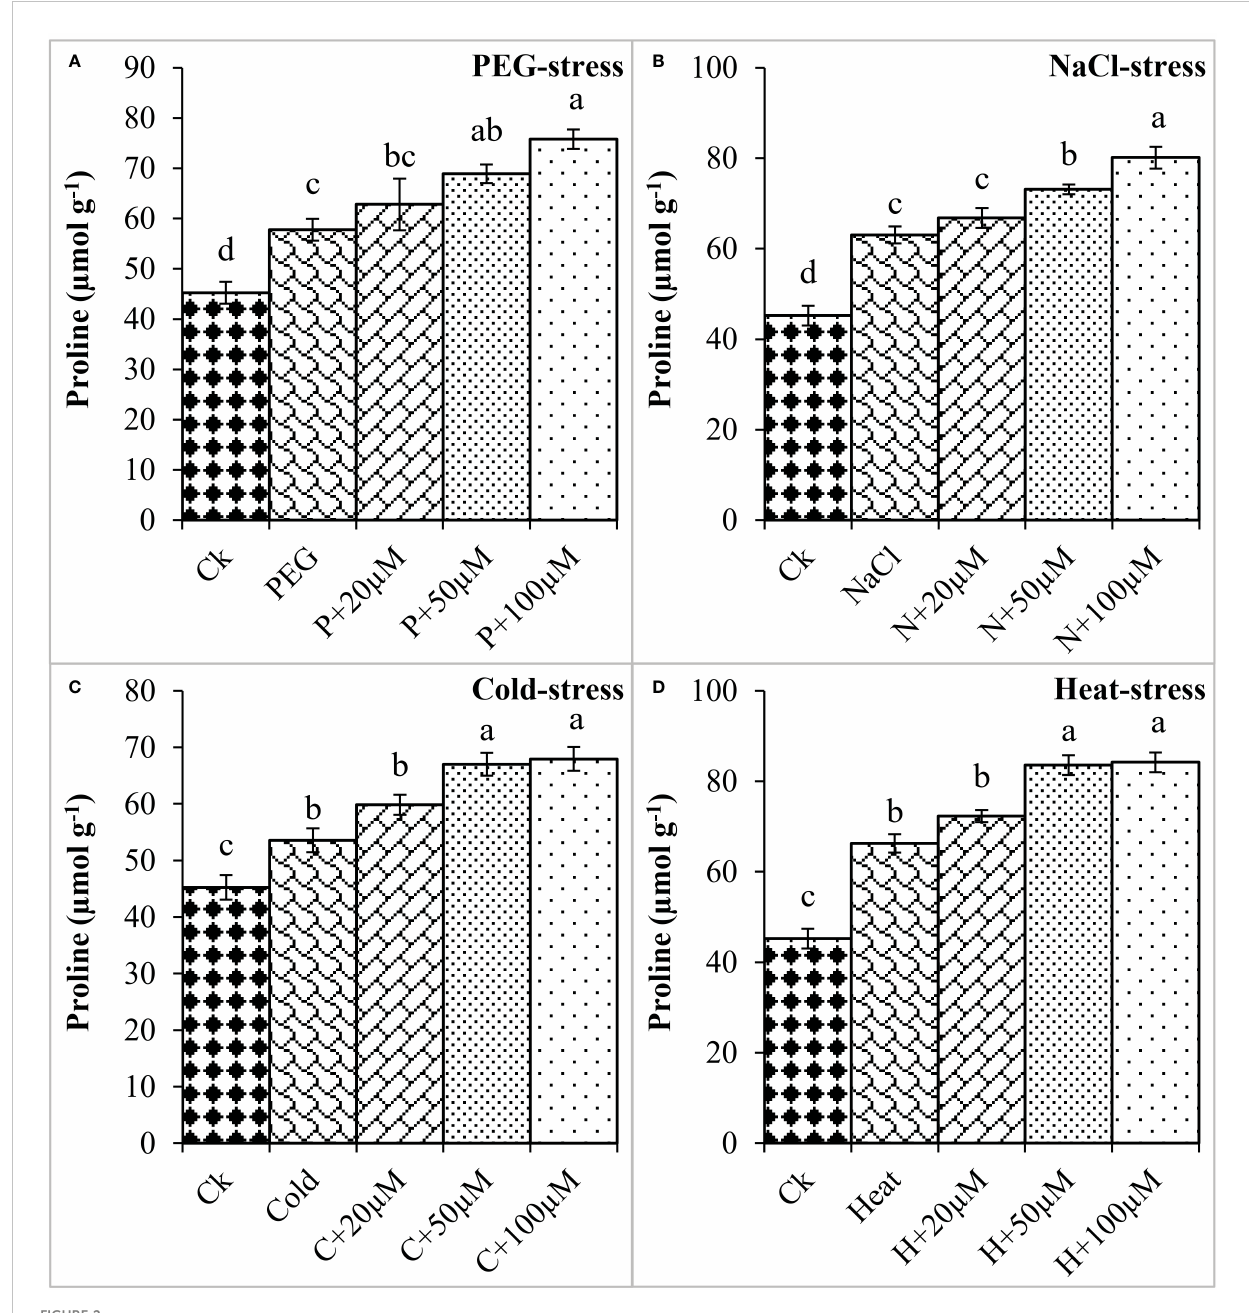
FIGURE 2 Effect of different concentrations of melatonin on the activity of Proline content under PEG (A) , NaCl (B) , Cold (C) , and Heat (D) . Values are the means ± SD (n=3). Different letters on the bars show a statistical signi fi cance level at p<0.05 . Here, µM is indicating (µmole L -1